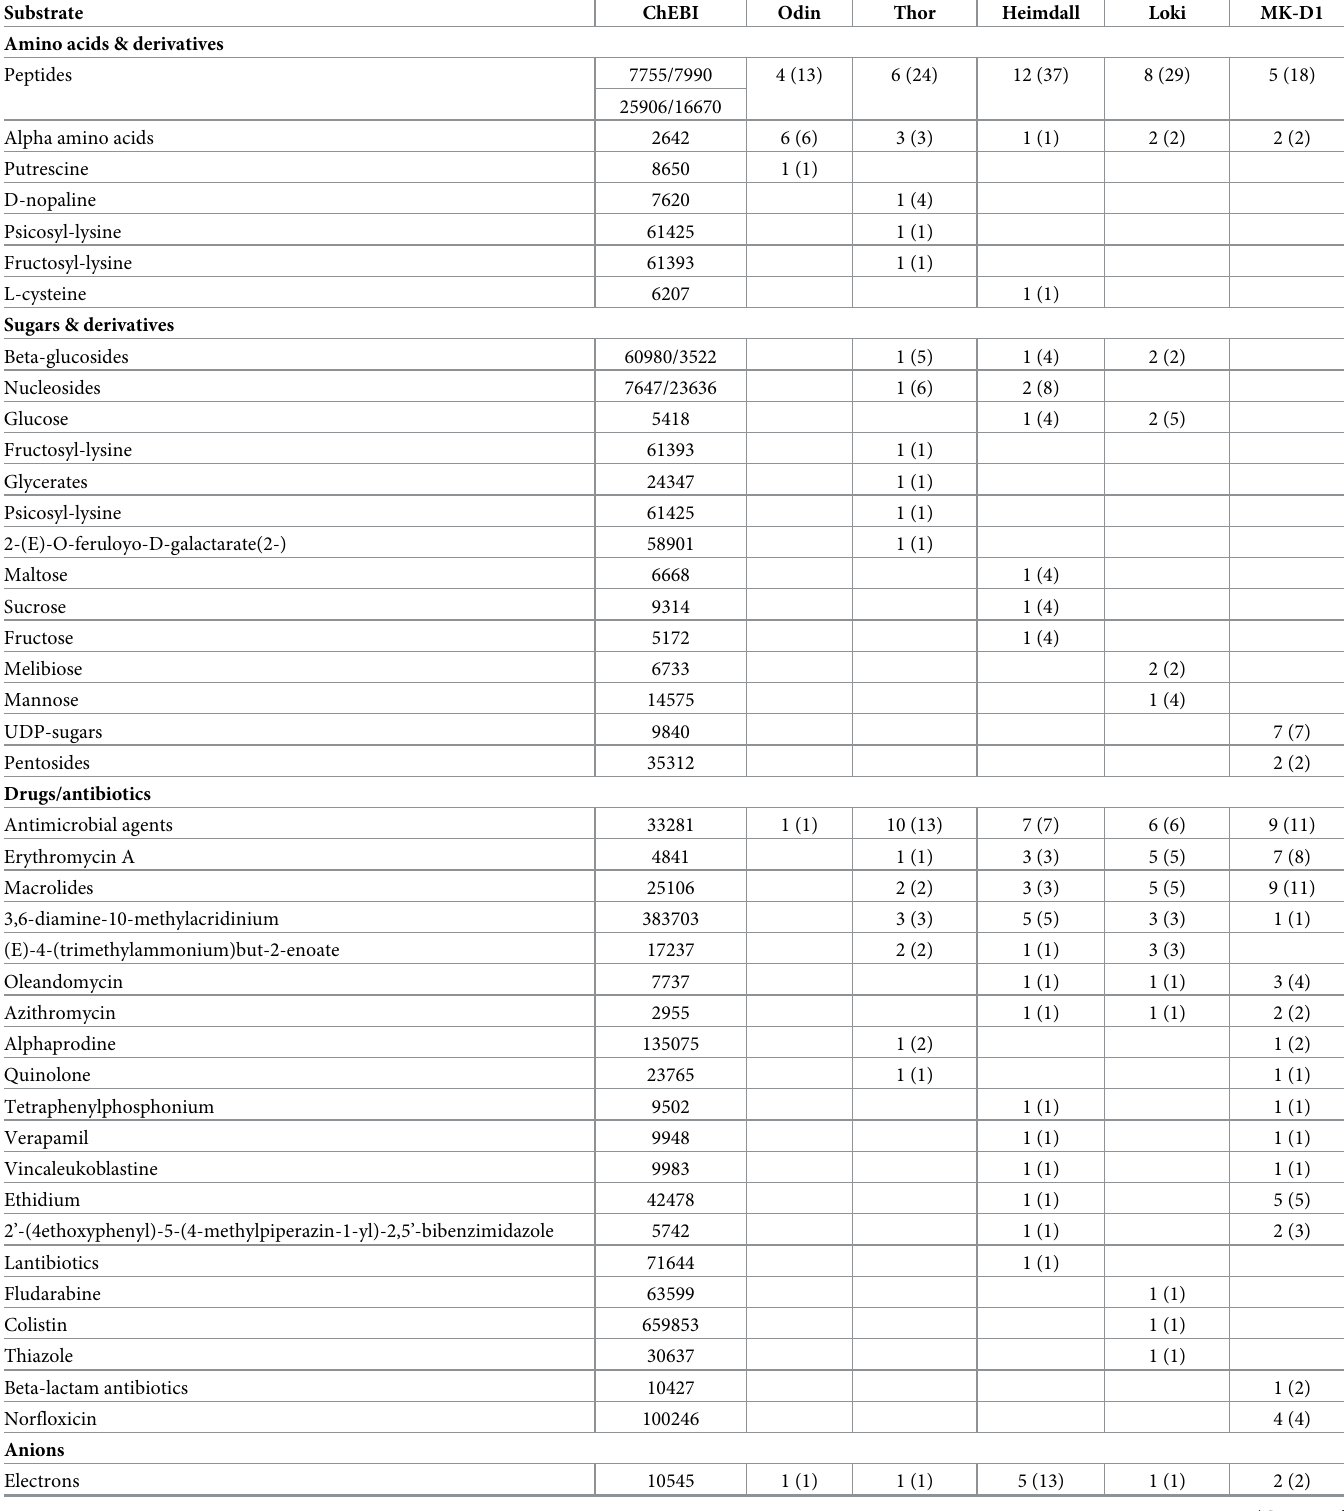
Table 3. Inferred substrates transported by Asgard